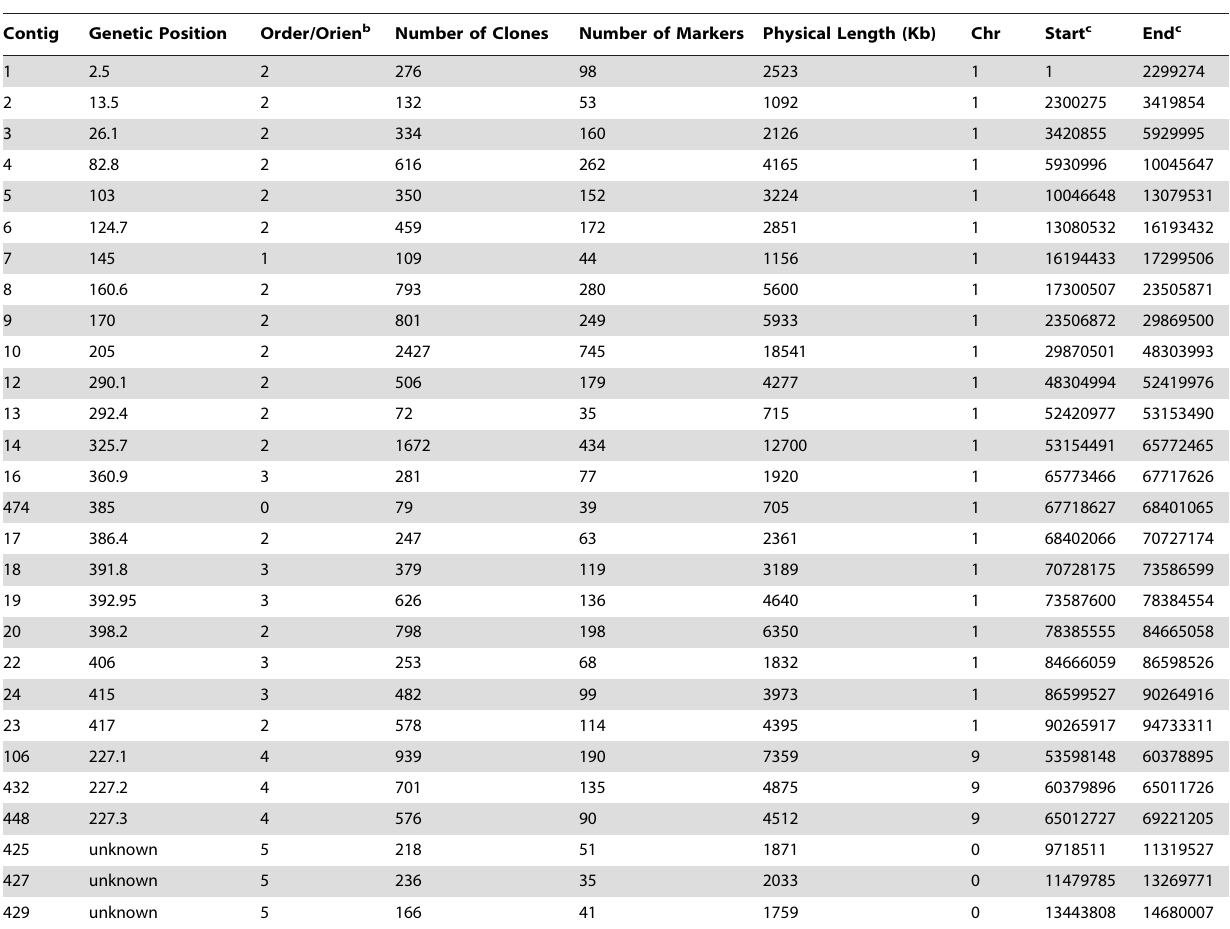
Table 2. Contig anchoring quality and contig positions in B73 RefGen_v1 a .